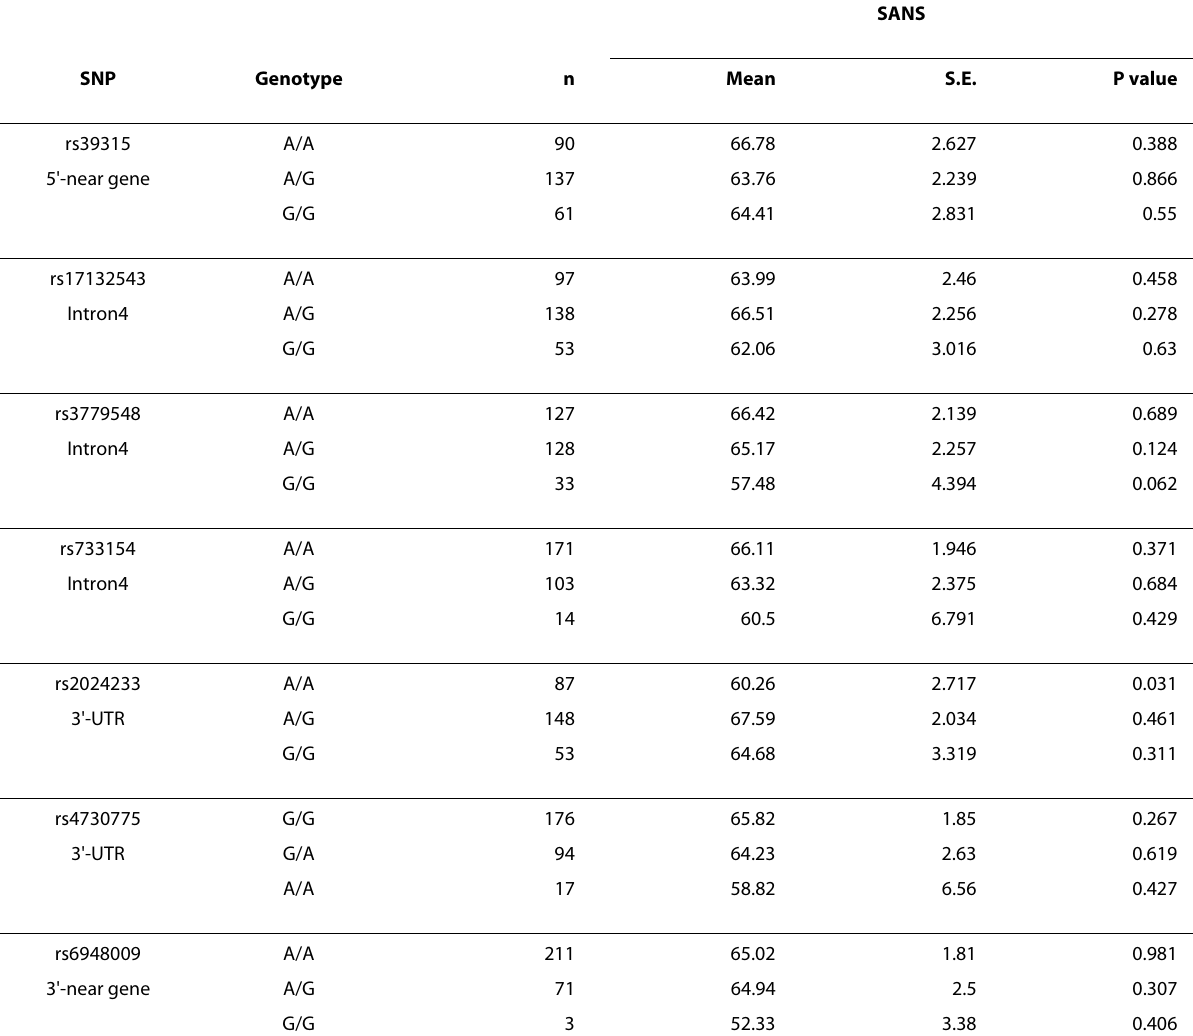
Table 5: Comparison of SANS scores between schizophrenic patient groups with different genotypes of WNT2